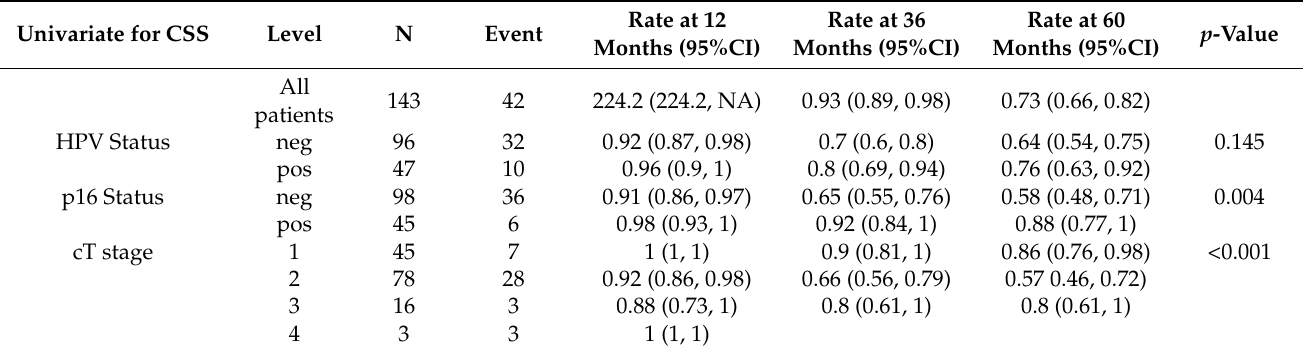
Table 3. Univariate Cox Analysis for CSS (Table 3) at 12 months (1 yr), 36 months (3 yr) and 60 months (5 yr). HPV and p16 status and other significant patient characteristics